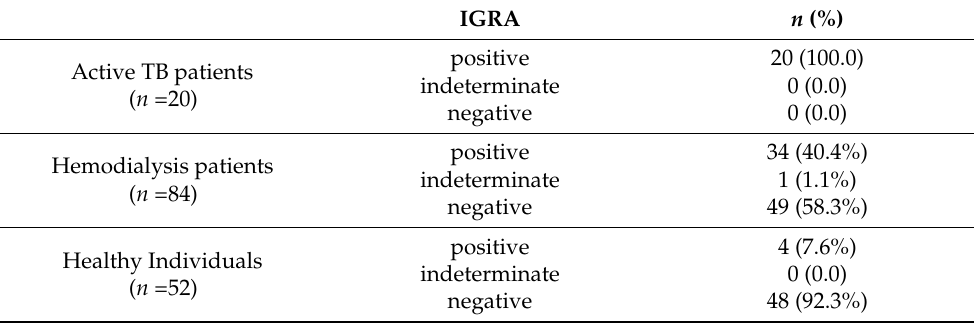
Table 2. IGRA results for active TB patients, hemodialysis patients, and healthy individuals.